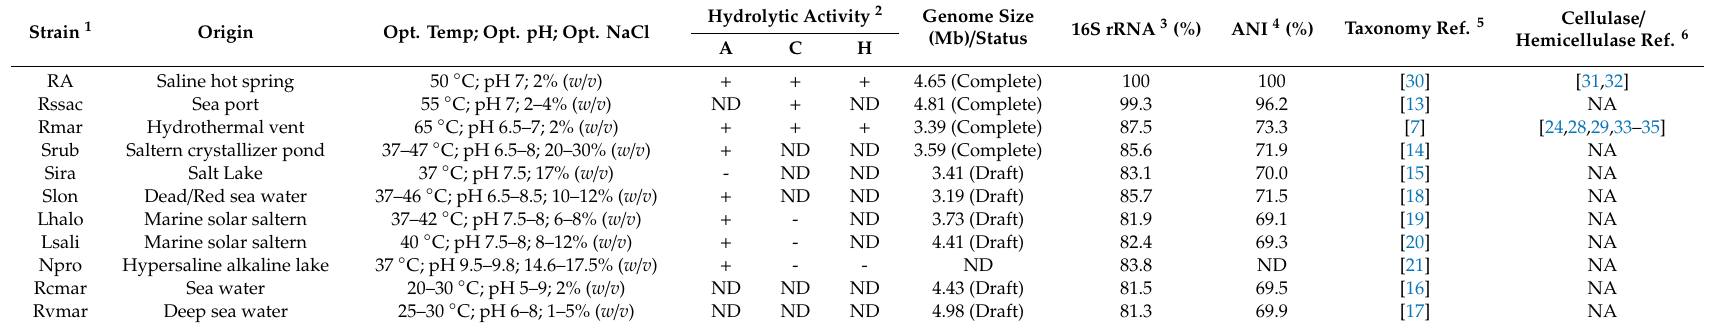
Table 1. The basic information of Rhodothermales